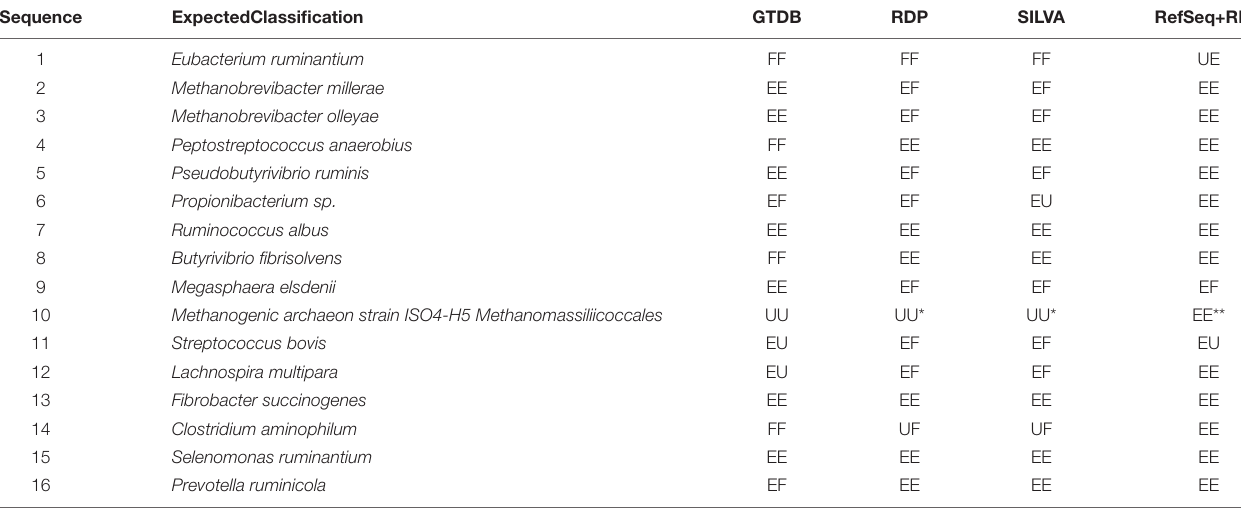
TABLE 3 | Expected vs. actual classification of bacterial ( n = 13) and archaeal ( n = 3) sequences included in reference standard by four databases at a bootstrapping threshold of 80.